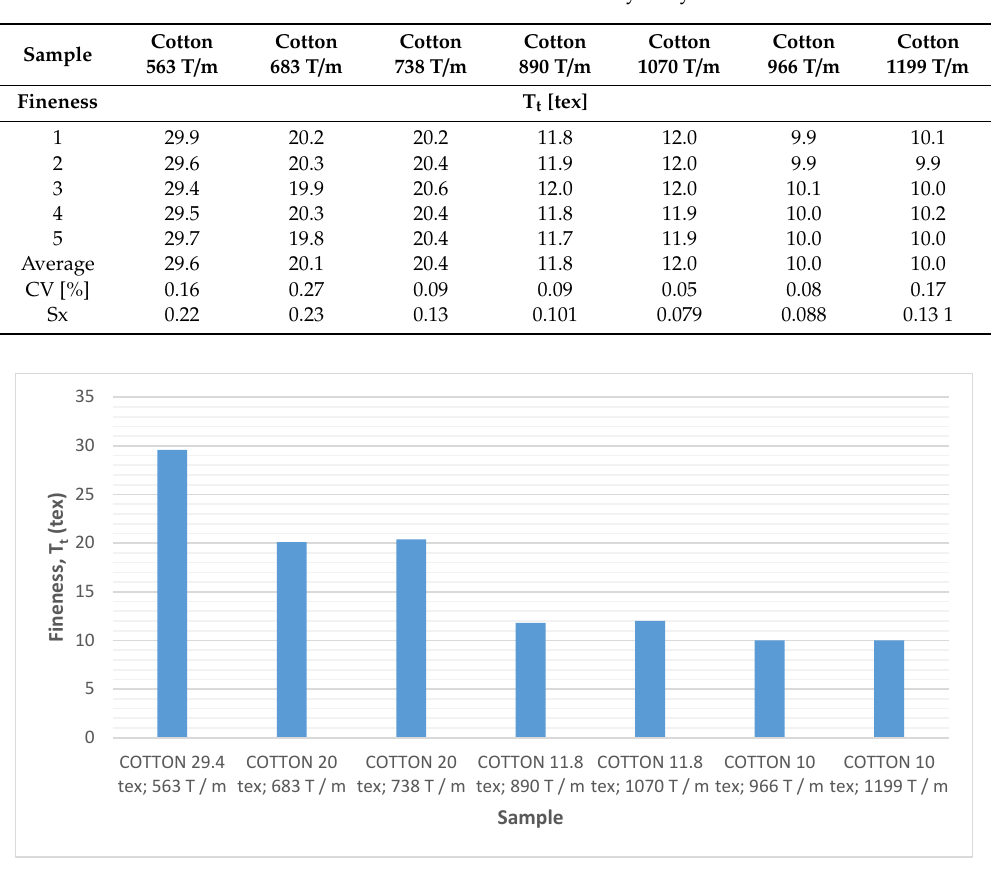
Figure 3. Average fineness of the analyzed yarns.